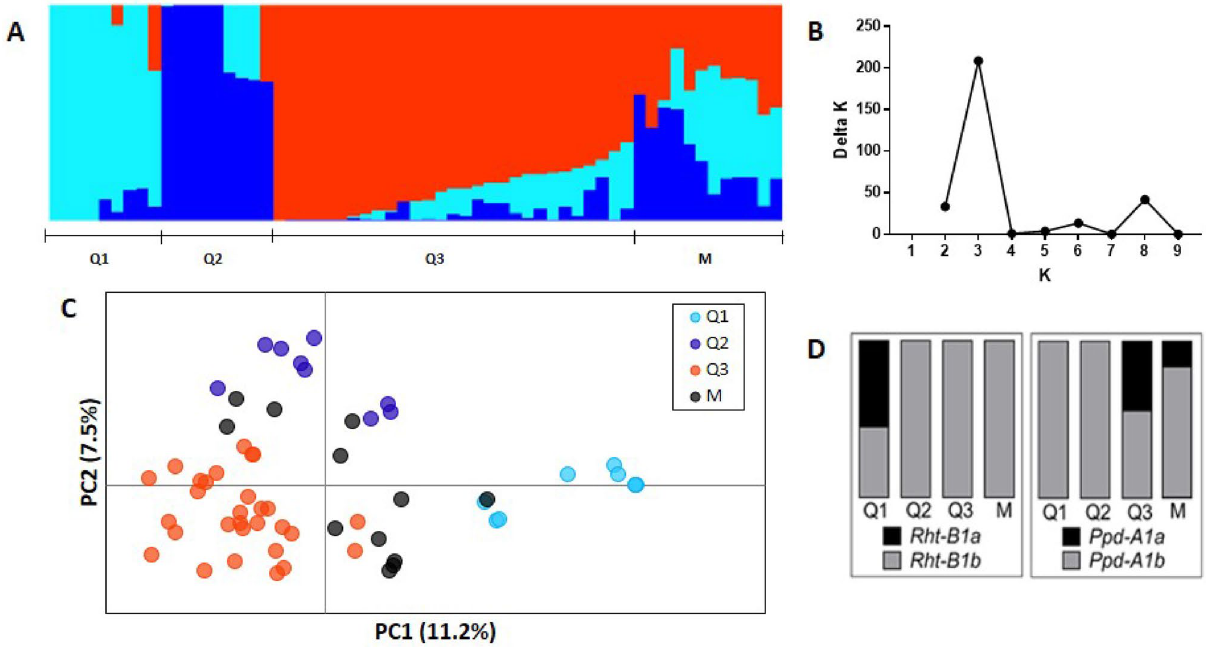
Figure 1. Population structure analysis for 59 Argentinian durum wheat genotypes assessed by 3565 SNP. (A) Barplot of the genotypes at K = 3 from STRU CTU RE software, (B) delta K values for the different genetic groups, (C) Principal Coordinate Analysis (PCoA) and (D) Rht-B1 and Ppd-A1 allele frequencies in each group defined by STRU CTU RE. Colors in the PCoA plot for each genotype correspond to the STRU CTU RE results at K = 3. M indicates the mixed group (% of membership < 0.6), in PCoA plot the mixed genotypes were colored in black.